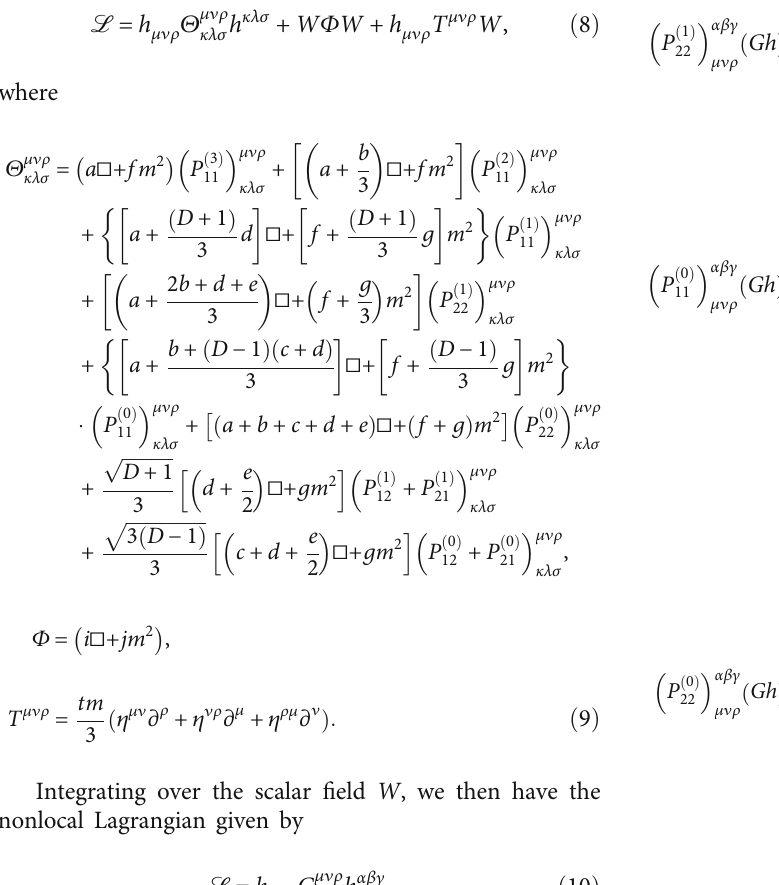
ffiffiffiffiffiffiffiffiffiffiffiffiffiffiffiffiffi 3 D − 1